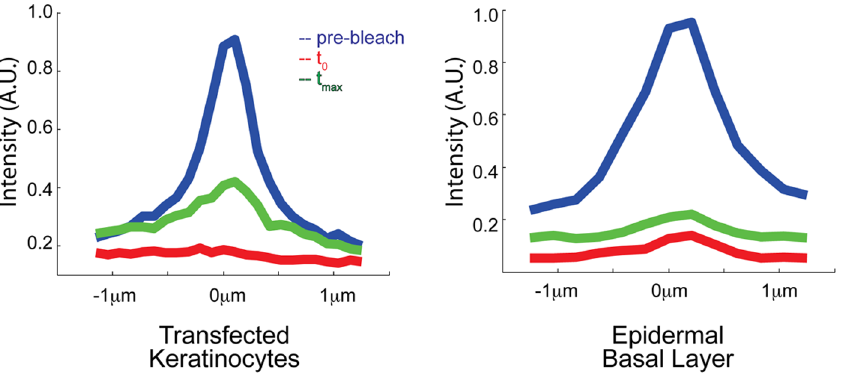
Figure 3. Intensity profiles of fluorescence recovery. Graphs show the average intensity profile across bleached junctions in E-cadherin-GFP transfected keratinocytes and in the basal layer of the epidermis from E-cadherin-CFP e17.5 embryos. Time points plotted are directly before bleaching (pre-bleach), directly after bleaching (t 0 ), and at maximum intensity recovery within five minutes (t max ). Each graph shows the average data from n . 8 junctions for each condition. Intensity is displayed in arbitrary units for each condition.